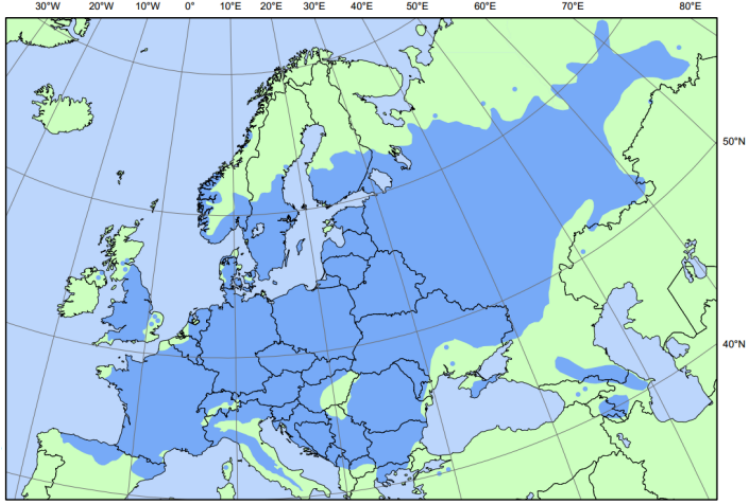
Figure 2. European distribution of T. cordata [91].